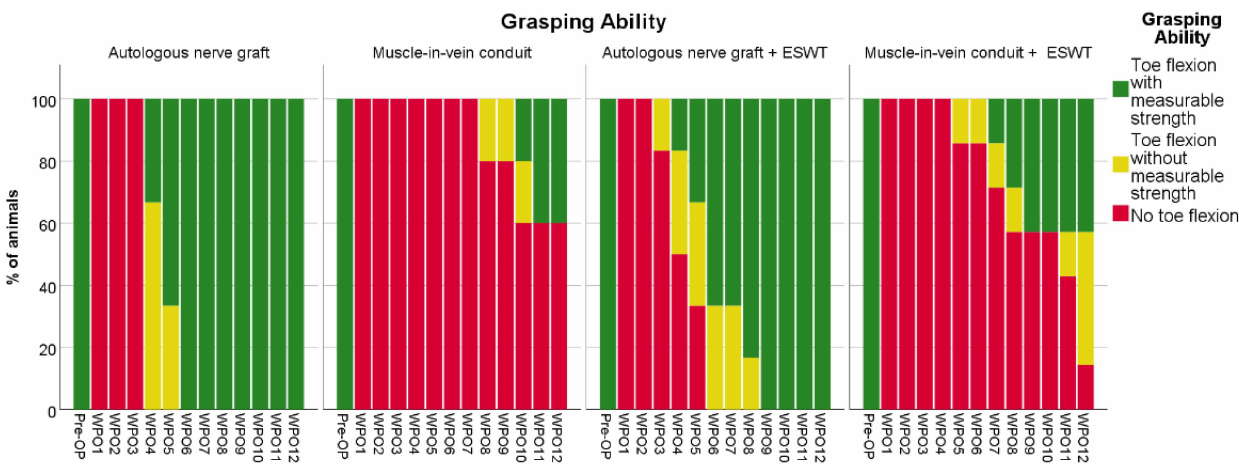
Figure 1. Recovery of the grasping ability following reconstruction of the right median nerve during the postoperative 12-week observation period. Autologous nerve graft ( n = 3); muscle-in- vein conduit ( n = 5); autologous nerve graft + ESWT: autologous nerve graft with postoperative extracorporeal shockwave therapy ( n = 6); muscle-in-vein conduit + ESWT: muscle-in-vein conduit with postoperative extracorporeal shockwave therapy ( n = 7). WPO: postoperative week. Table 1. Summary of functional recovery as assessed by the grasping ability (1/3: no toe flexion; 2/3: toe flexion without measurable strength; 3/3: toe flexion with measurable strength) during